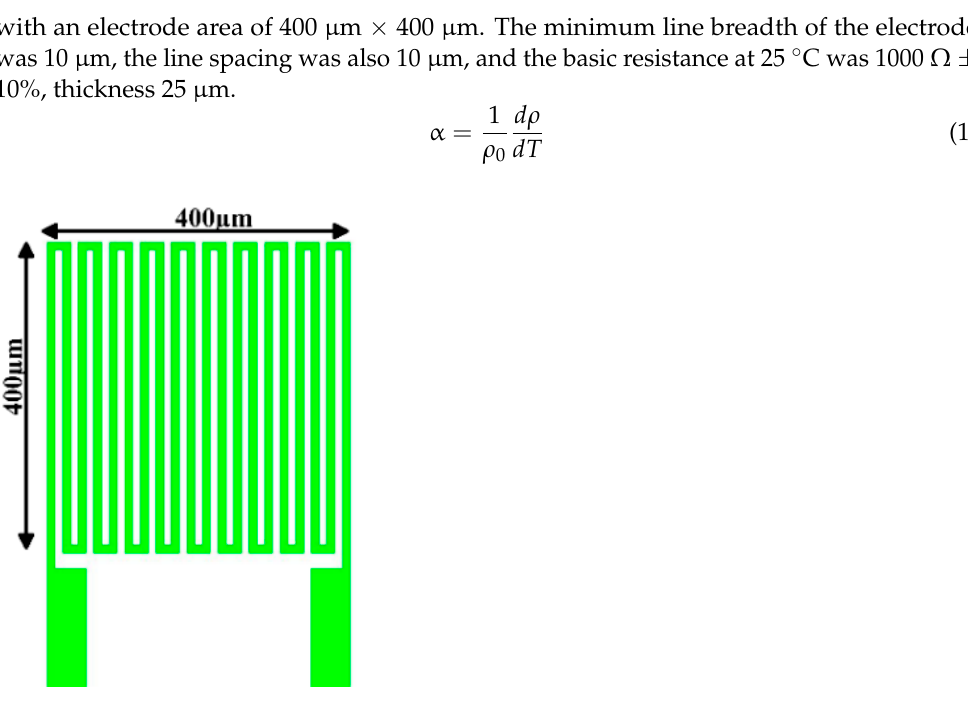
Figure 1. Principle and design of micro-temperature sensor.